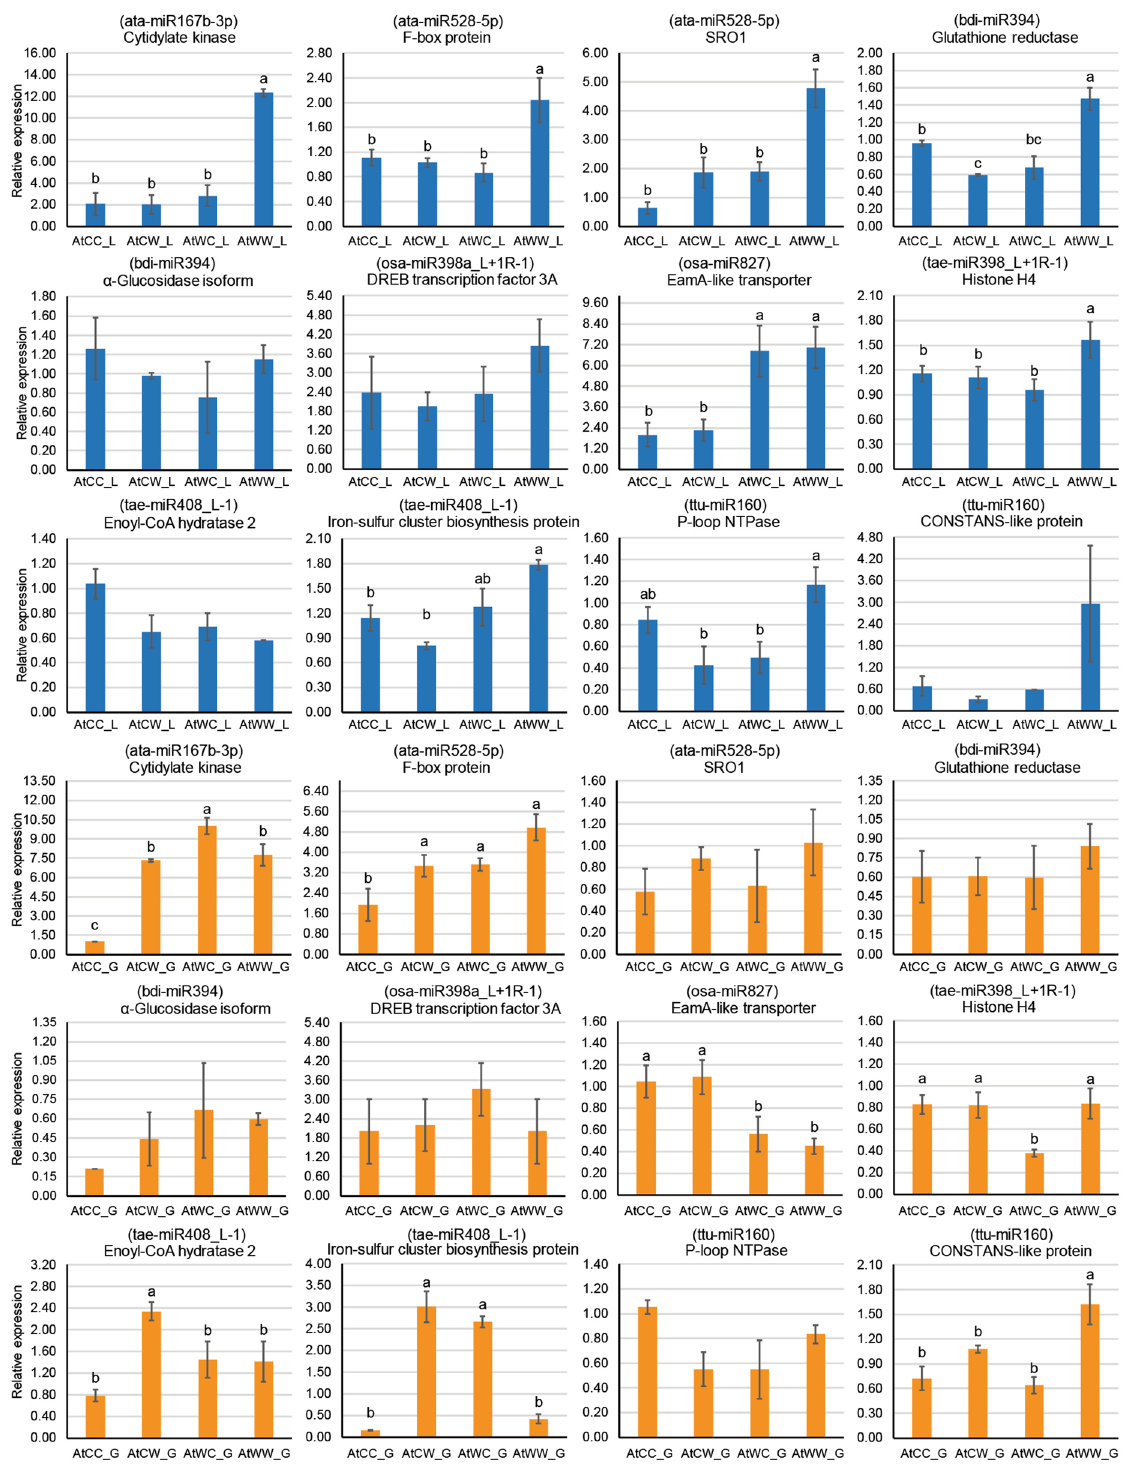
Figure 5. qPCR analysis of 12 stress-responsive target genes in the flag leaf tissue (denoted with _L, highlighted in blue) and in the developing grains (denoted with _G, highlighted in orange) of DBA Artemis. The miRNA targeting the gene is shown in brackets. Relative gene expression was calculated using GAPDH as the housekeeping gene. Data are represented as the mean ± standard error (SE) (n = 3). One-way ANOVA was used to determine statistical significance across treatment groups at P < 0.05 with the l.s.d. value (least significant difference). Different letters ( a – c ) denote the statistical difference across the treatment groups. The treatment groups are: AtCC (DBA Artemis control group parents, progeny treated with control), AtCW (DBA Artemis control group parents, progeny treated with water-deficit stress), AtWC (DBA Artemis water-deficit stress group parents, progeny treated with control), AtWW (DBA Artemis water-deficit stress group parents, progeny treated with water-deficit stress). SRO1, poly [ADP-ribose] polymerase SRO1